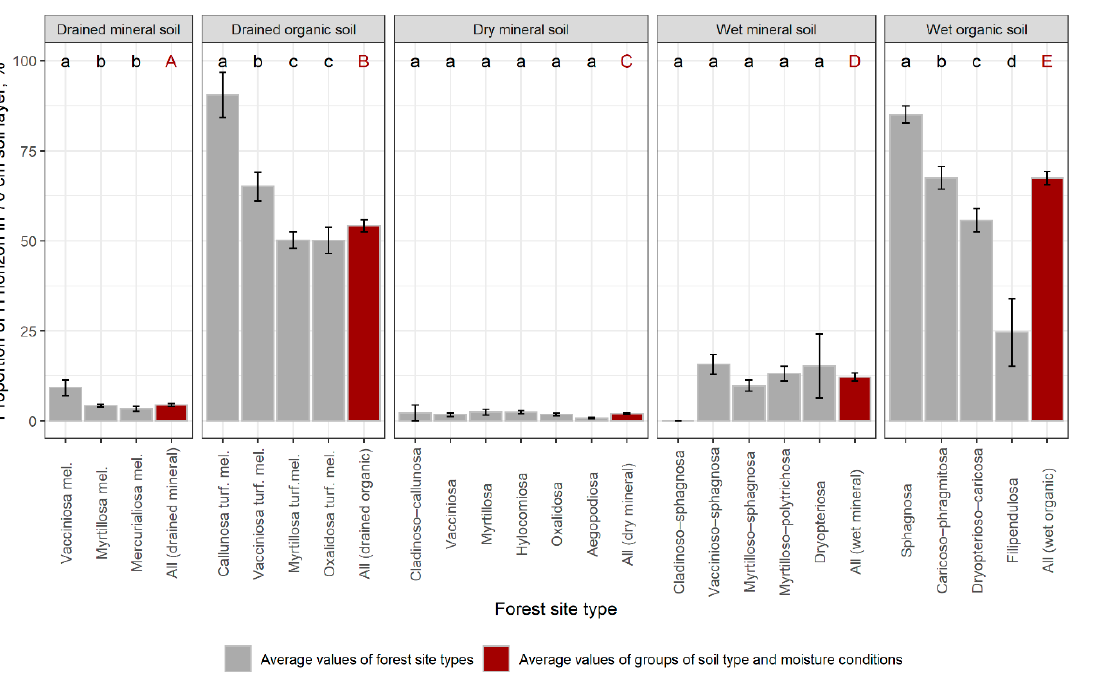
Figure 3. Distribution of thickness of the O horizon in forest land in Latvia depending on basal area. The division into groups based on soil types and moisture conditions is based on forest site types according to the national forest classifica- tion.